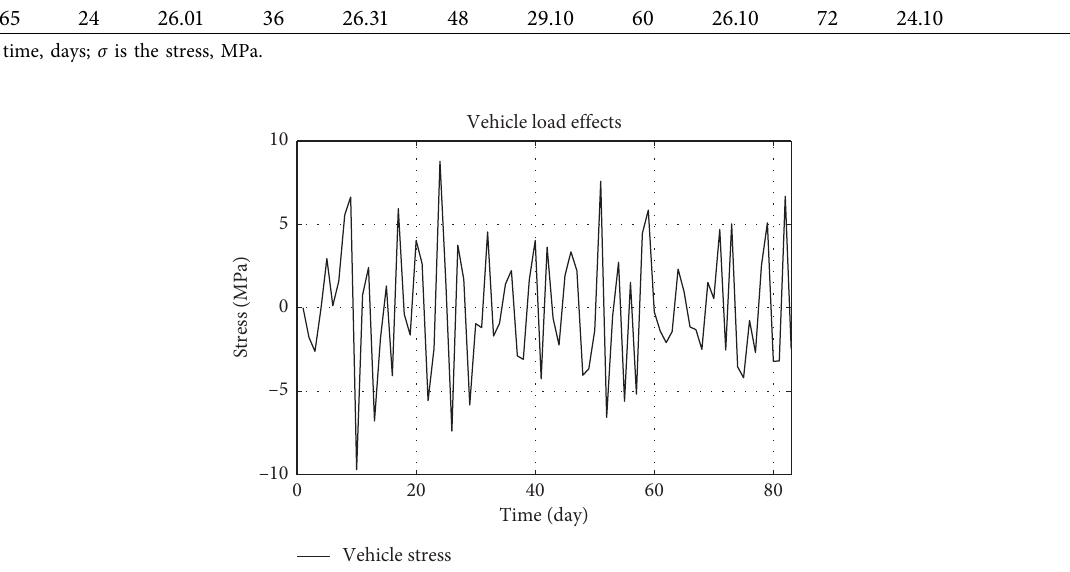
Figure 3: Decoupled vehicle load effects for 83 days. Table 3: Decoupling vehicle load effects’ data for 83